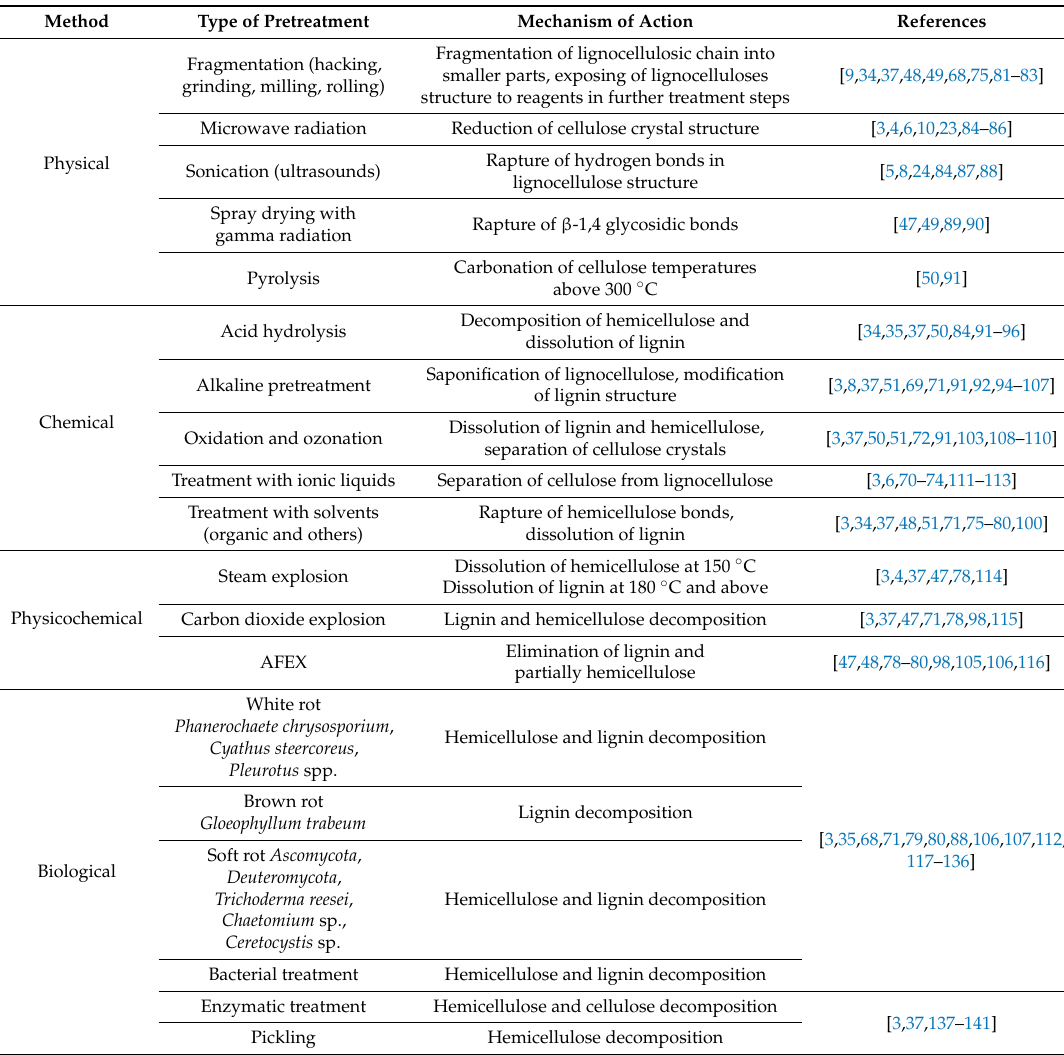
Table 3. Methods of lignocellulose